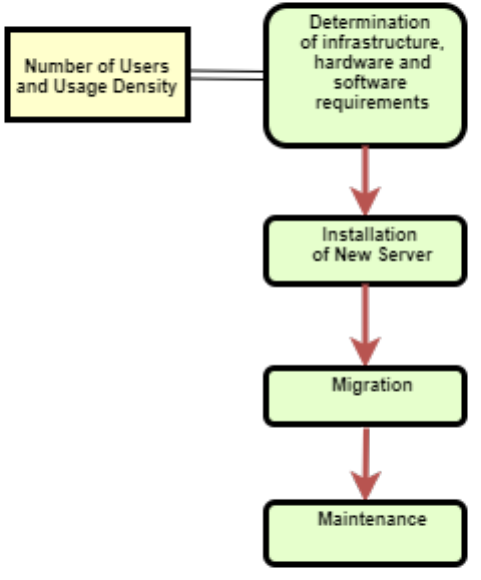
Figure 1. Server migrating